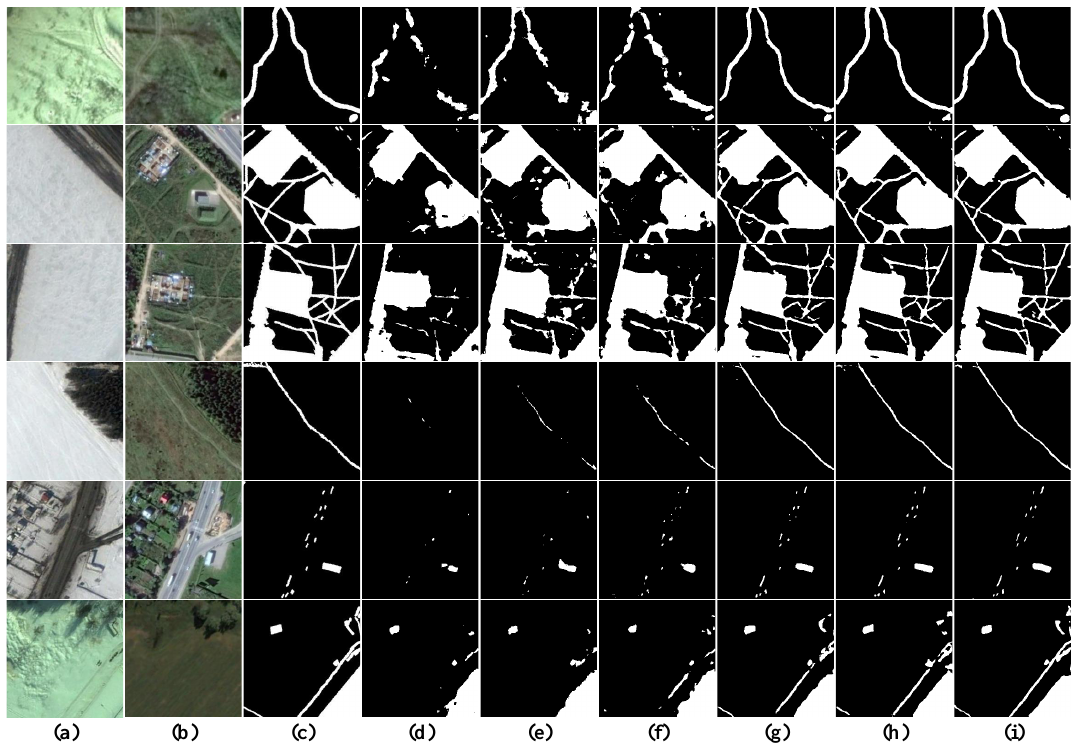
Figure 11. Visualization results of ablation experiments performed on CDD dataset. ( a ) T1 im- ages. ( b ) T2 images. ( c ) Ground Truth. ( d ) Baseline. ( e ) Baseline + A-R. ( f ) Baseline + AFFM. ( g ) Baseline + HARM. ( h ) Baseline + AFFM + HARM. ( i ) Baseline + A-R + AFFM + HARM. White indicates the predicted change area, black indicates the predicted unchanged